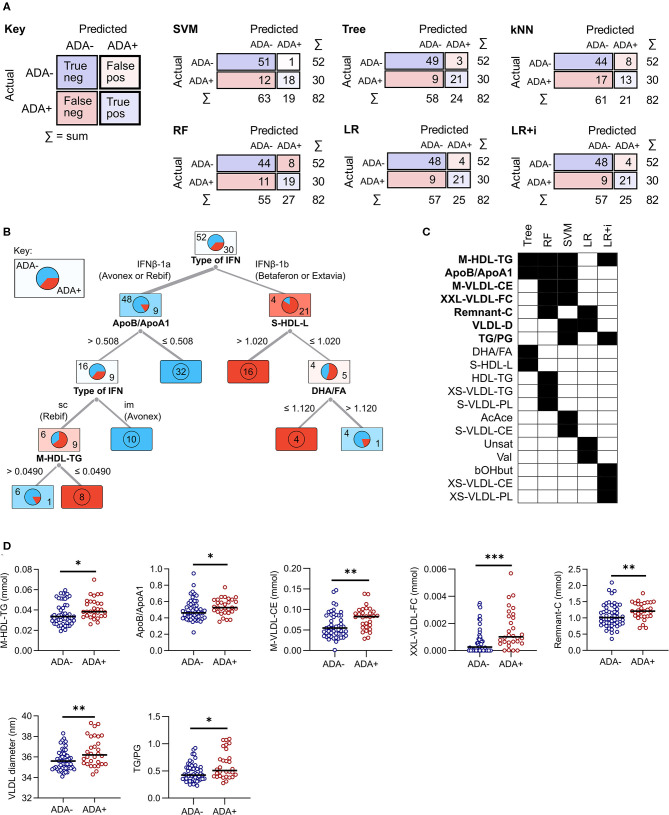
Comparison of predictive model performance at M0. (A) The confusion matrix shows the number of correct (blue squares) and incorrect (pink squares) classifications for each model. The sum (Σ) of each row and column is given. The algorithms used were support vector machine (SVM), decision tree (Tree), k-nearest neighbors (kNN), random forest (RF), and lasso logistic regression (LR) with and without interactions (i). (B) A graphical representation of the decision tree, where each square shows the proportion of patients who stay ADA negative (top left, blue) or become ADA positive (bottom right, red). The numbers on the branches representcut-off concentrations (mmol) or ratios (ApoB/A1 and TG/PG). (C,D) A comparison of the metabolites selected by each machine learning model. For RF and SVM only metabolites within the top 10 predictors are included. Metabolites selected by more than one method are highlighted in bold and shown as dot plots in (D). Line shows the median, and significance was determined by Mann Whitney U; *p < 0.03, **p = 0.01, ***p = 0.0003. im, intramuscular; sc, subcutaneous.